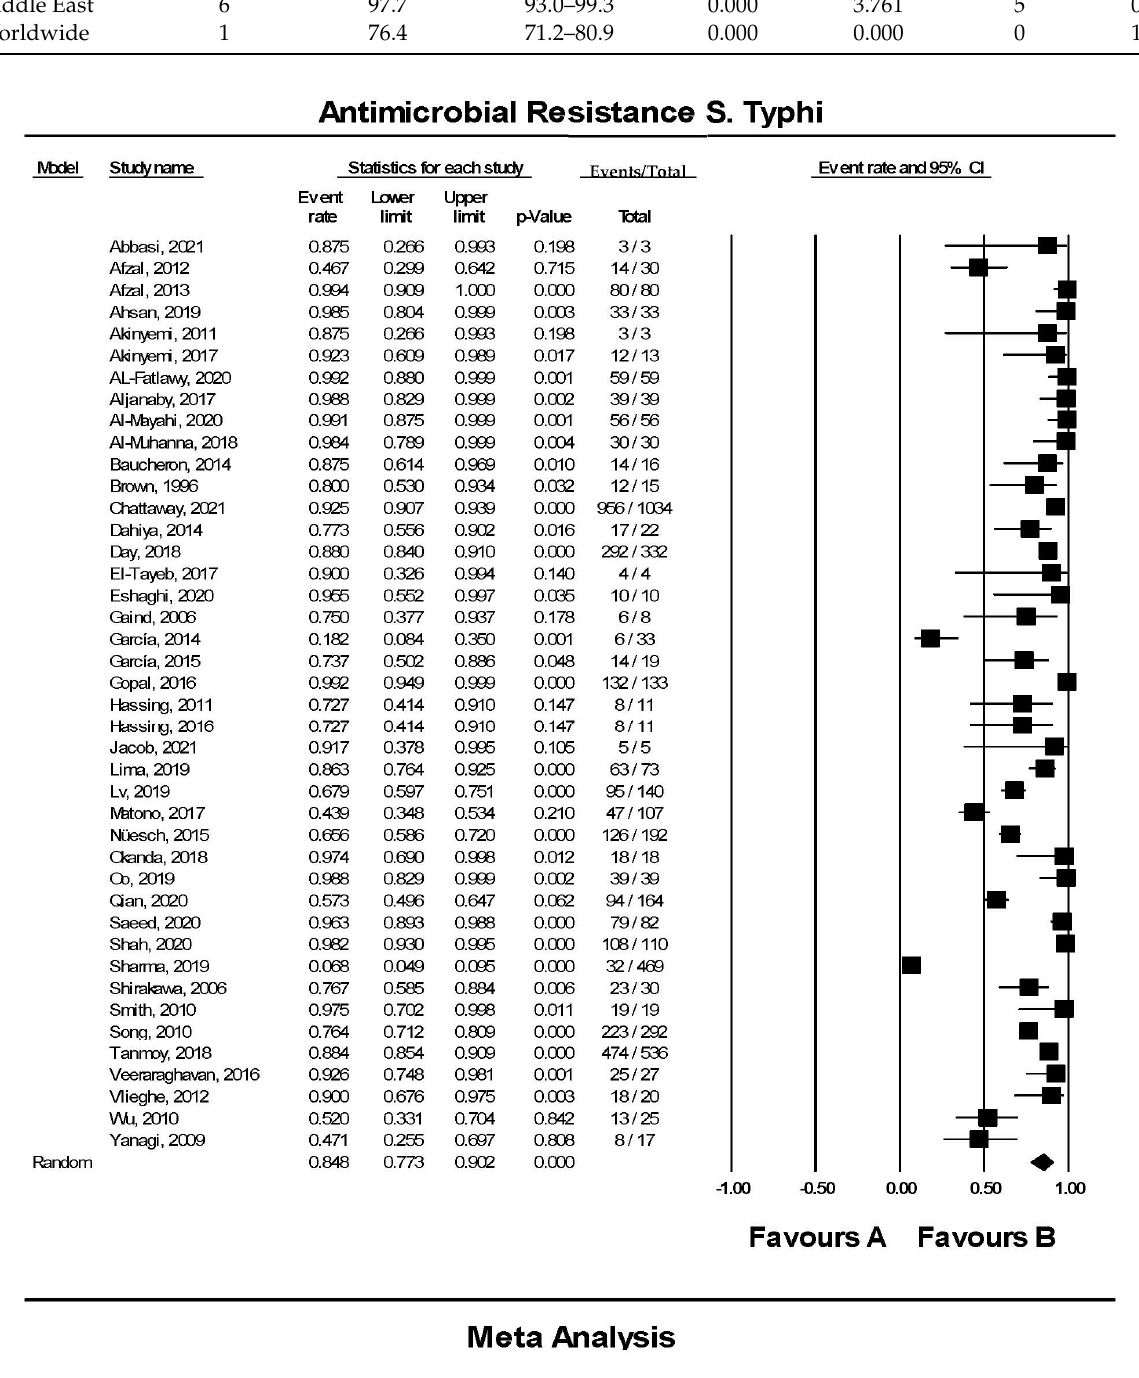
Figure 3. Forest plot showing the pooled prevalence of resistant S. Typhi isolates estimated by